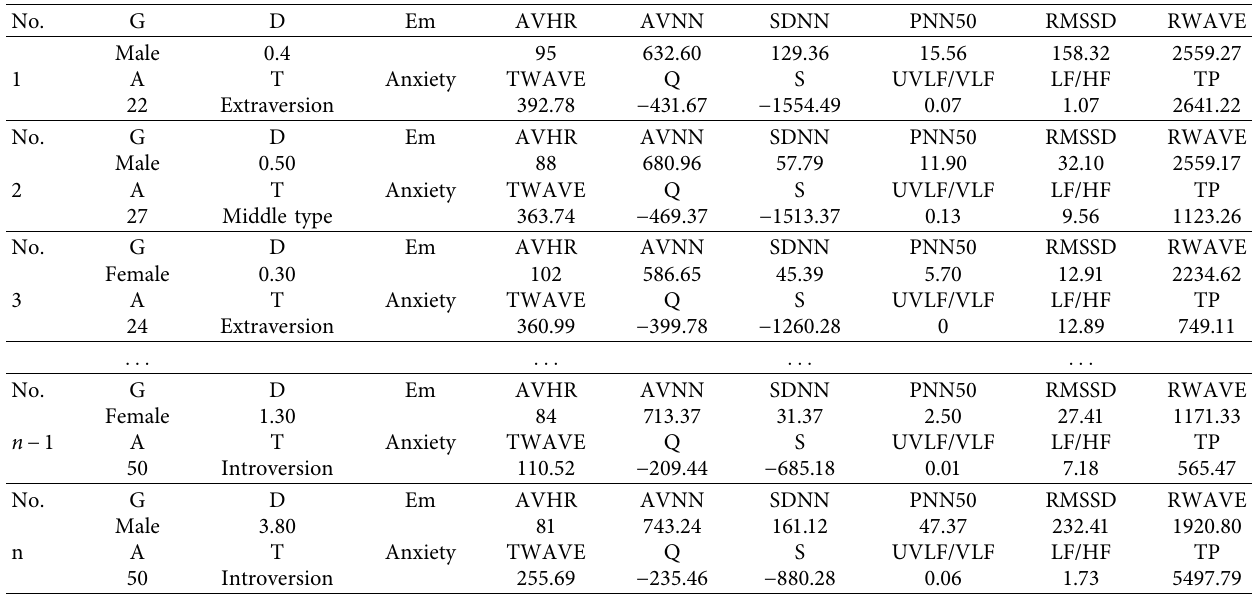
Table 5: Statistics of driver’s ECG characteristic data.